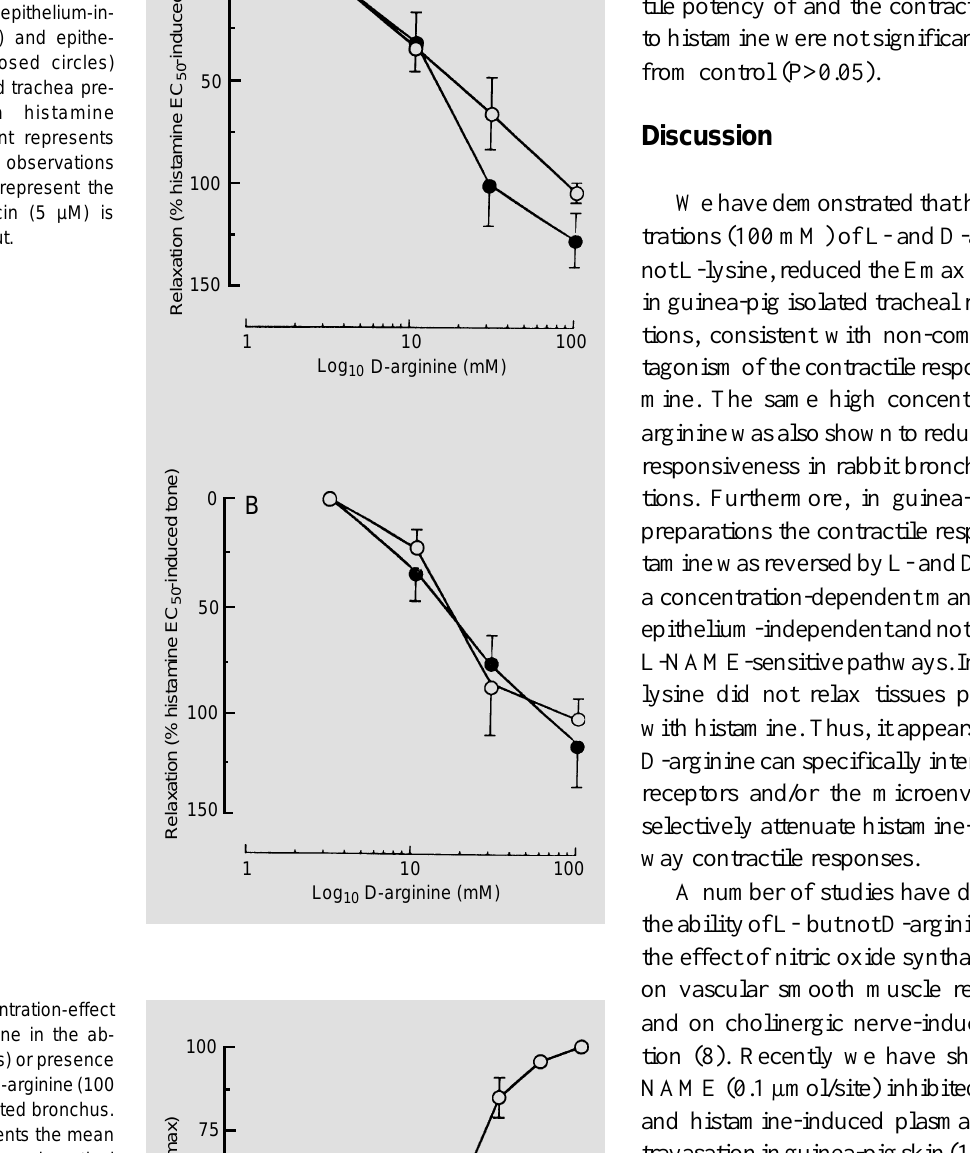
(M)Figure 6 - Concentration-effect curves for histamine in the ab- sence (open circles) or presence (closed circles) of L-arginine (100 mM) in rabbit isolated bronchus. Each point represents the mean of 8 observations and vertical bars represent the SEM. In- domethacin (5 µM) is present throughout.